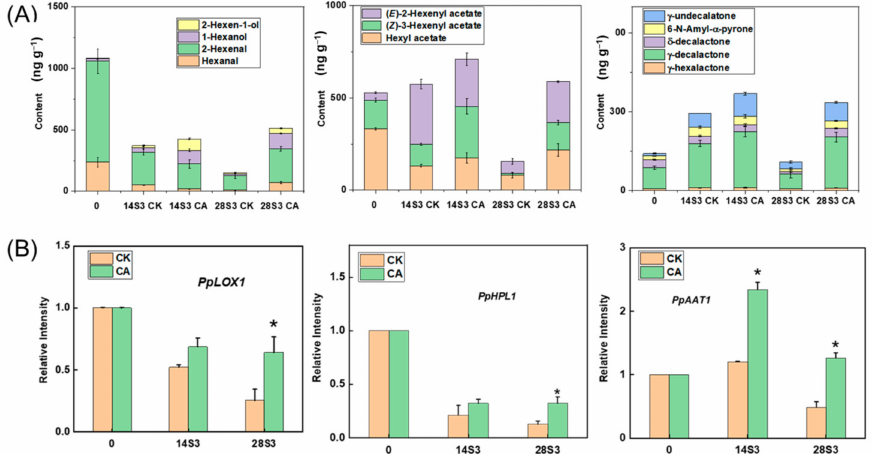
Figure 7. Change of the VOC and related genes expression derived from fatty acid LOX pathway during shelf-life. ( A ) Content of peach fruit VOC; ( B ) Relative intensity of gene expression. All data were from three biological replicates. Data are expressed as the means ± standard error of three biological replicates, and the * indicated the statistical significance of the two samples with the unpaired Student’s t -test (* p <